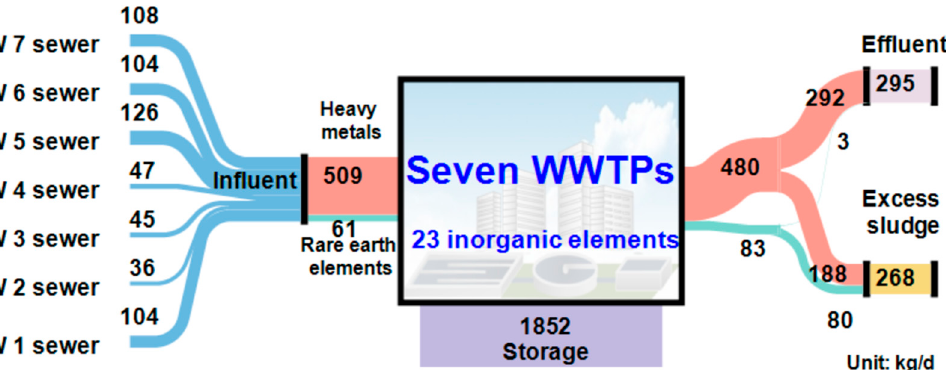
Figure 4. Elemental flux at 7 WWTPs (unit was kg · d − 1 ). The flow from sewer to WWTP represents inflow of elements, while the flow discharged from WWTP represents the output of elements from effluent and excess sludge. Storage gives an indication on elemental flow saved in WWTP. The 23 elements are classified as heavy metals and REEs. Heavy metals (light coral) including Zn, Cr, Cd, Sb, Tl, Pb, Mn, Co, Ga, and V; REEs (aquamarine) including Y, La, Ce, Pr, Nd, Sm, Eu, Gd, Dy, Ho, Er, Tm, and Yb.